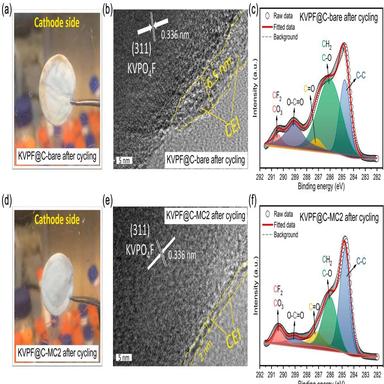
Separator digital photos (a and d), HRTEM images (b and e) and high-resolution C1s XPS spectra (c and f) of the KVPF@C-bare and KVPF@C-MC2 electrodes harvested from full-cells after 100 cycles.